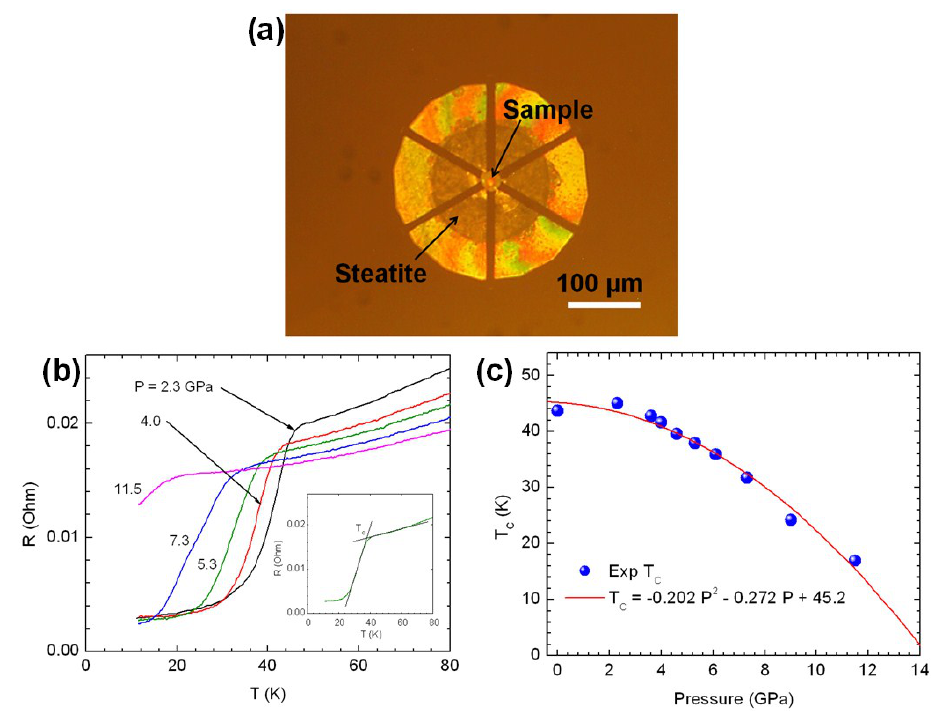
Figure 3. ( a ) Ca 0.9 Pr 0.1 Fe 2 As 2 sample loaded in a diamond anvil cell along with